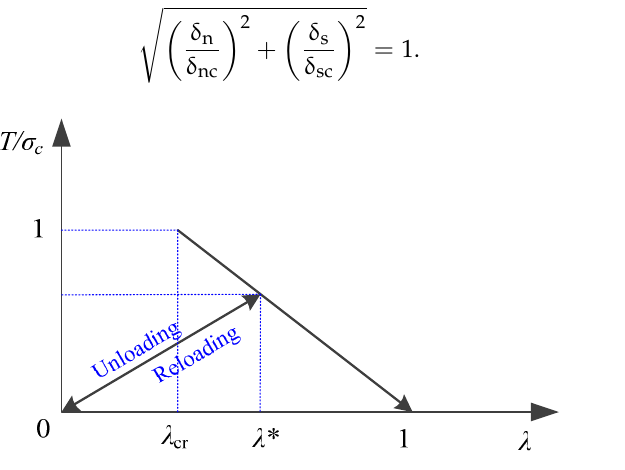
Figure 4. Linear traction–separation law.